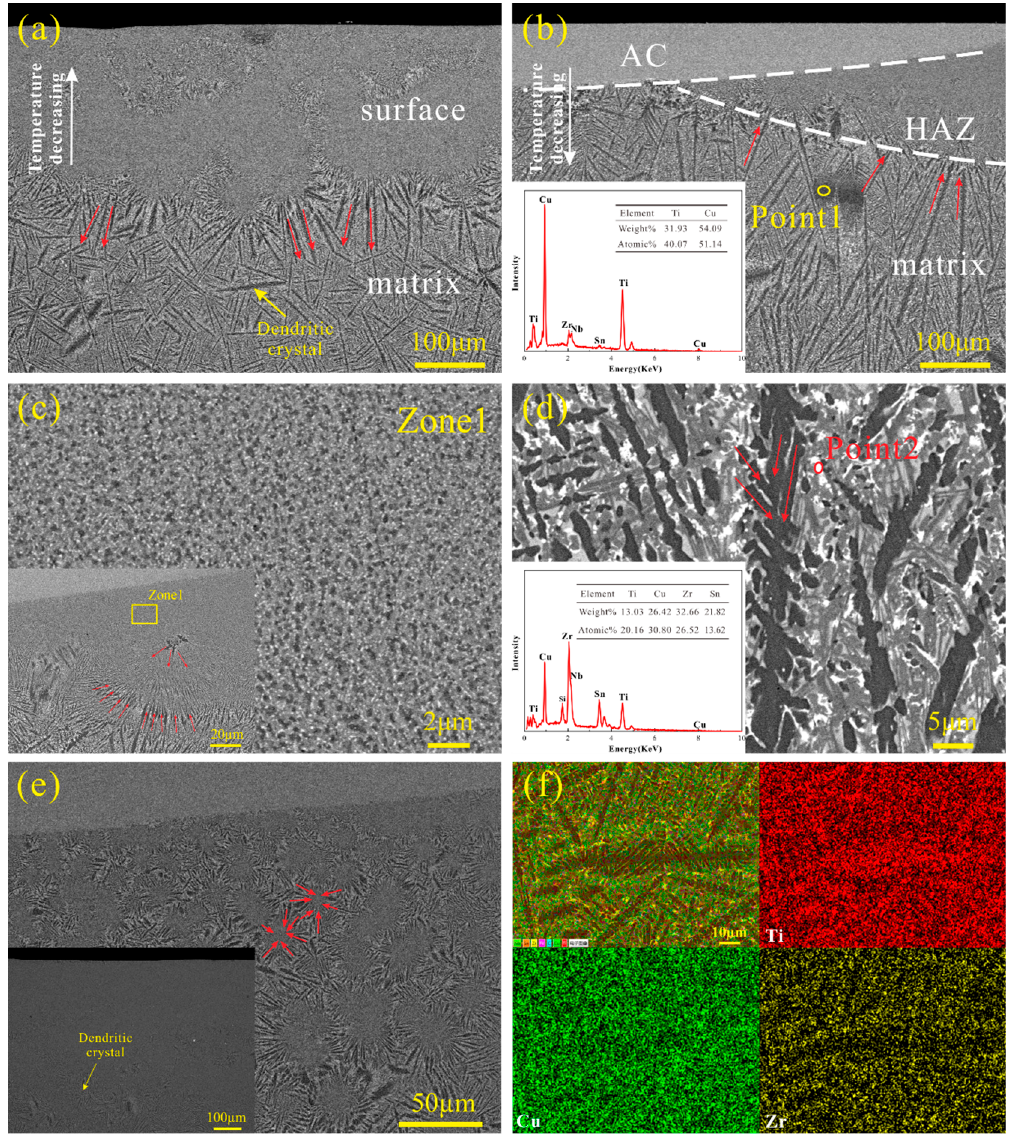
Figure 3. Back-scattered scanning electron microscopy (SEM) micrographs of the ( a ) cross-section of the 2 mm Ti alloy untreated; ( b ) the 2 mm sample under 200 W and the Energy-dispersive X-ray spectroscopy (EDX) corresponding to point 1; ( c ) Heat affected zone (HAZ); and ( d ) matrix regions in the sample with 2 mm under 200 W at high magnification and the EDX of point 2; ( e ) the 1.5 mm sample under 160 W with the inset showing untreated; ( f ) SEM-EDX mapping of dendritic crystals in sample with 2 mm under 200 W.